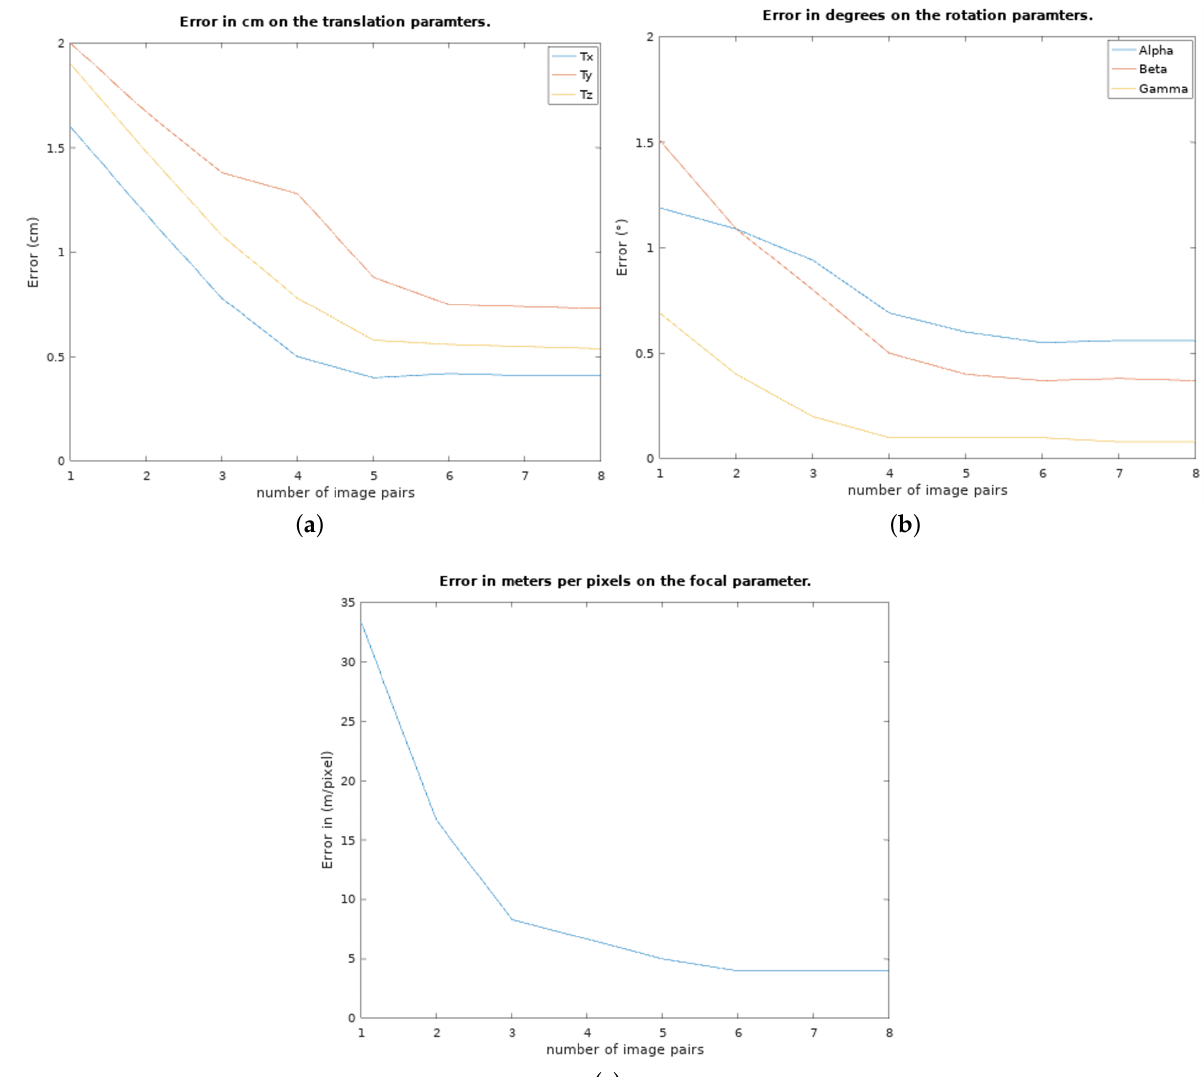
Figure 13. ( a ) The evolution of the mean error on the calibration parameters over the number of image pairs used. In ( a ), the translation parameters ( T s , T y , and T z ) are presented in meters, ( b ) the rotation parameters ( α , β , and γ ) in degrees, and ( c ) is the focal